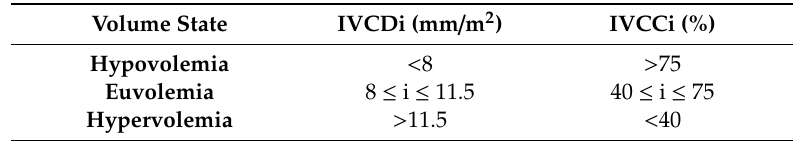
Table 5. Volume state in relation to the measuring ranges of the inferior vena cava diameter index to the body surface and the inferior vena cava collapsibility index